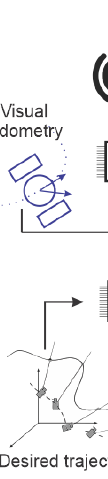
Figure 10. Camera pose control operation.